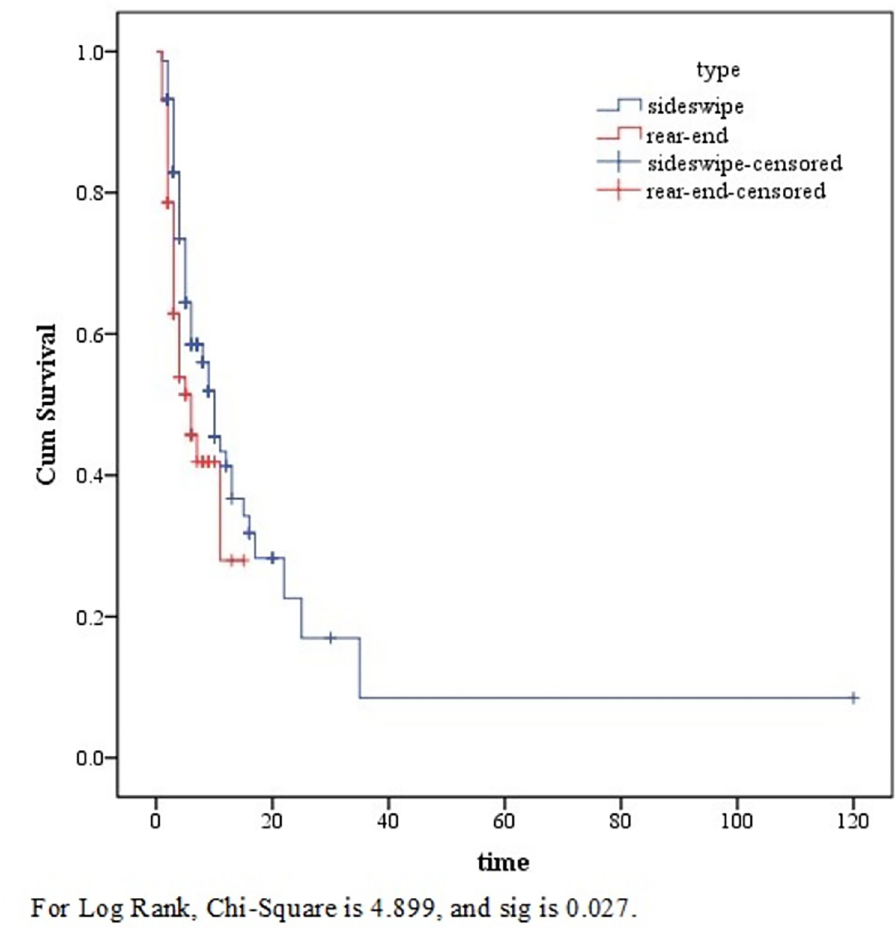
Fig 2. The figure of non-parametric survival analysis